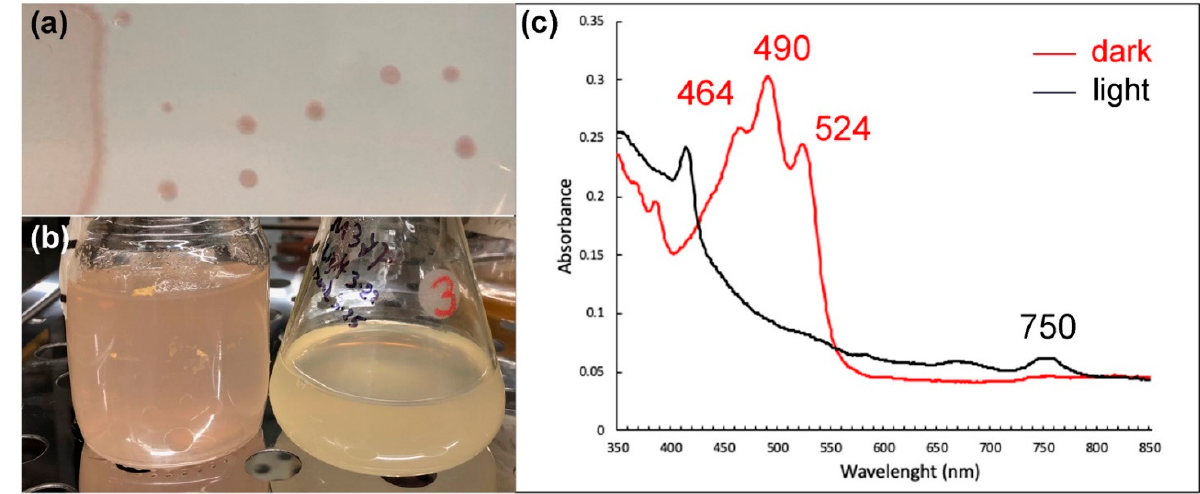
Figure 4. ( a ) Colonies of Rhodobacter sp. M37P grown on dark-incubated Thermus medium plates. ( b ) Dark- (left) and light- (right) incubated aerobic liquid cultures of strain M37P. ( c ) Absorption spectra of extracted pigments from dark-incubated (red) and light-incubated (black) aerobic Rhodobacter sp. M37P cultures. Spectral peak maxima are indicated.